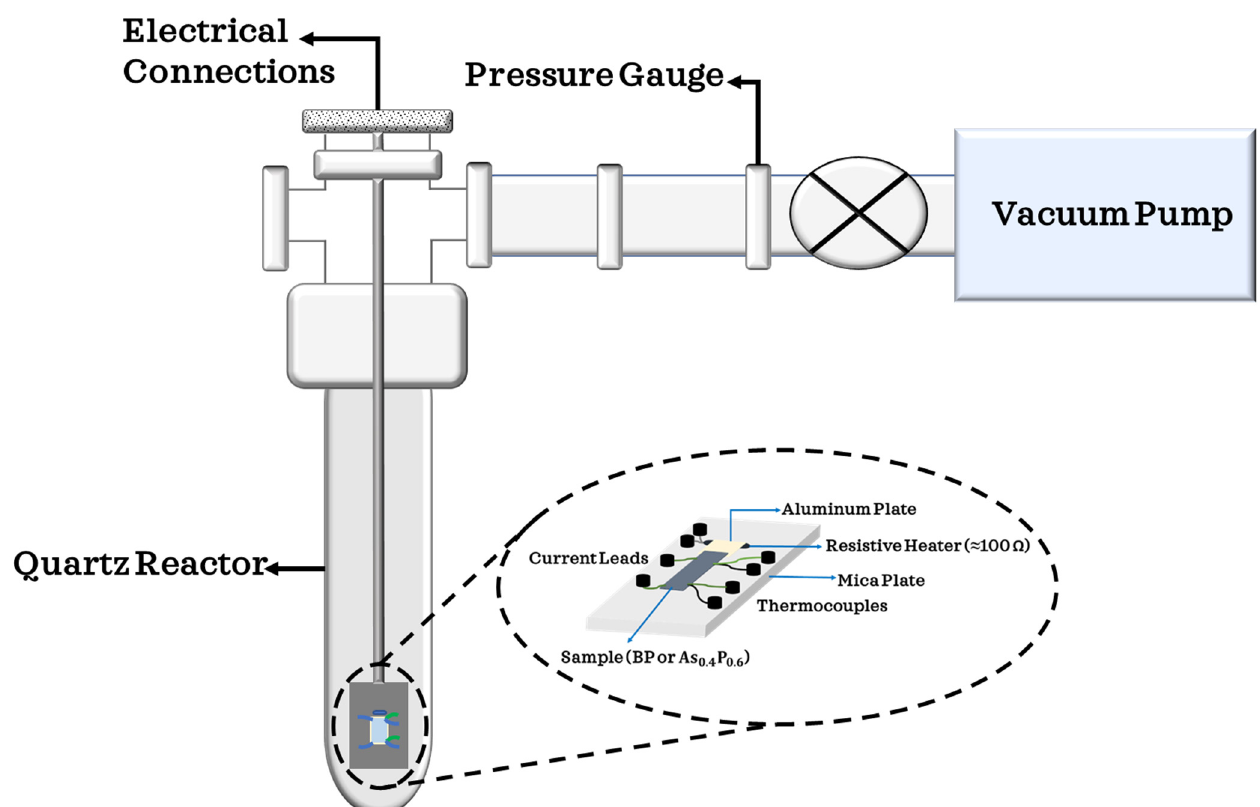
Figure 1. Experimental set-up for electrical transport measurements showing the reactor with provisions for pumping and air exposures and the sample probe and the electrical contacts.